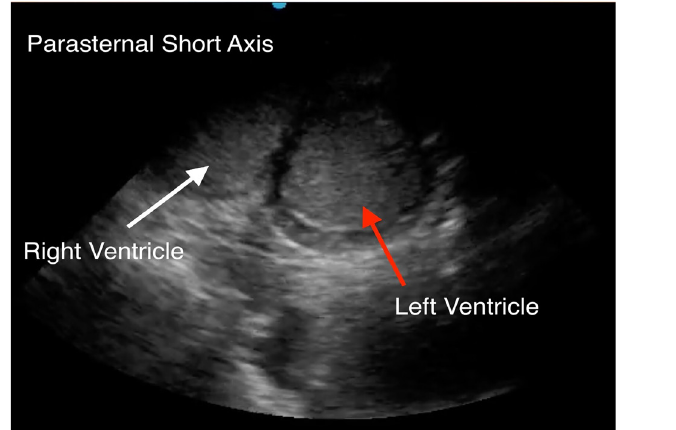
Image 2. Transthoracic echocardiography: parasternal short view of the heart demonstrating echogenic (thrombosed) blood within the left and right